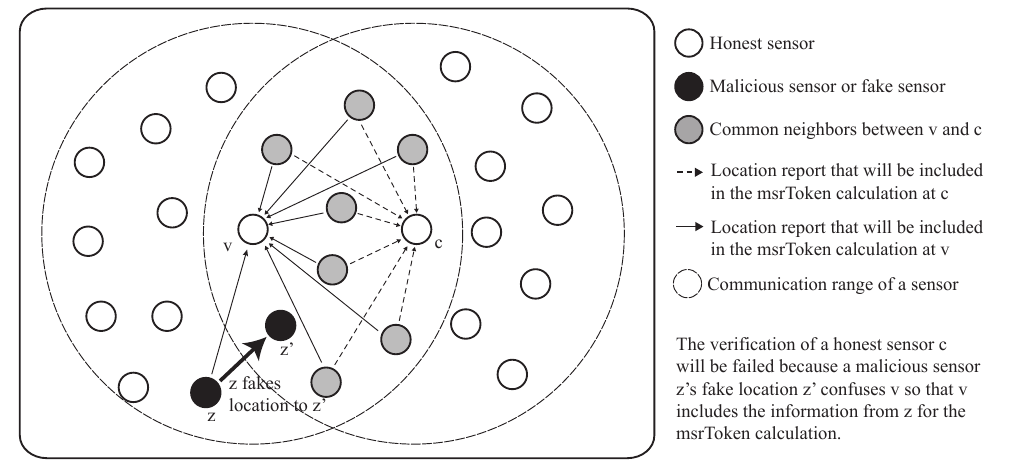
Figure 6. Verification failure